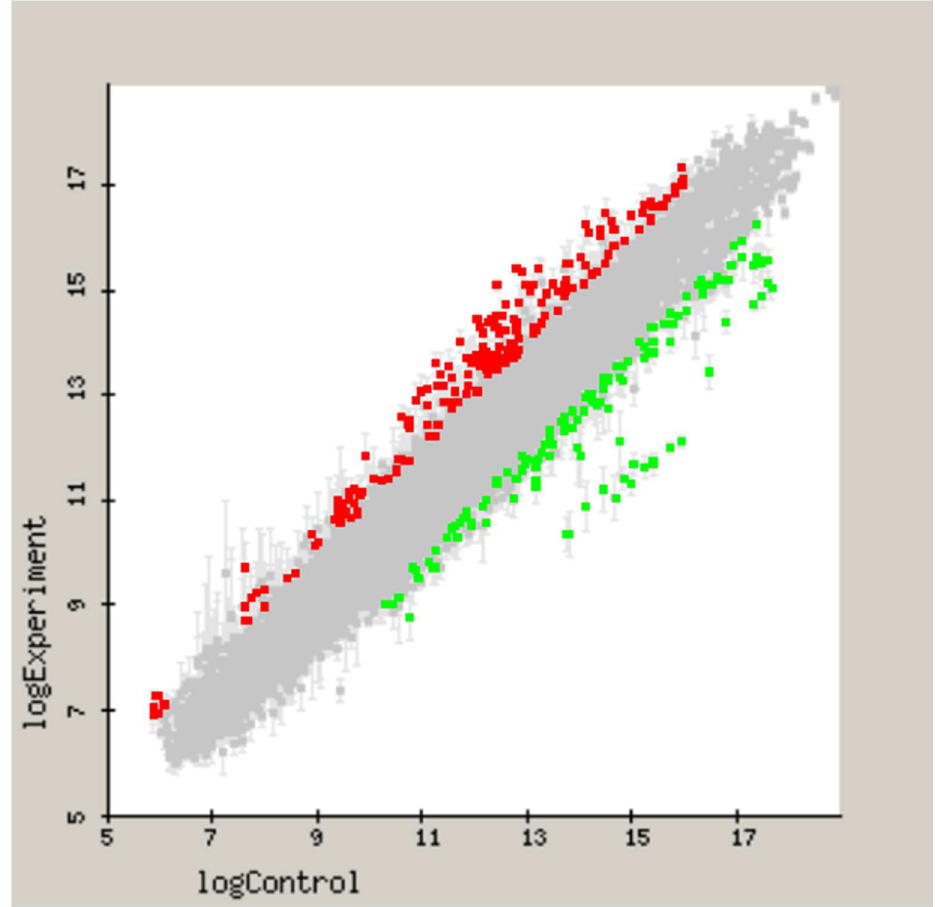
Fig 2. Differential gene expressionin Porphyromonas gingivalis ATCC 33277 biofilm as opposed to planktonic cells. Differentially expressedgeneswith 2.0 fold change (up or down) and p-value < 0.05 were plotted. X-axis presents fold difference betweenlog expressionof planktonic, and y-axis shows the log expressionof biofilm. Up-regulated genes (over-expressed in biofilm) were representedas red color and down-regulatedgenes were colored in